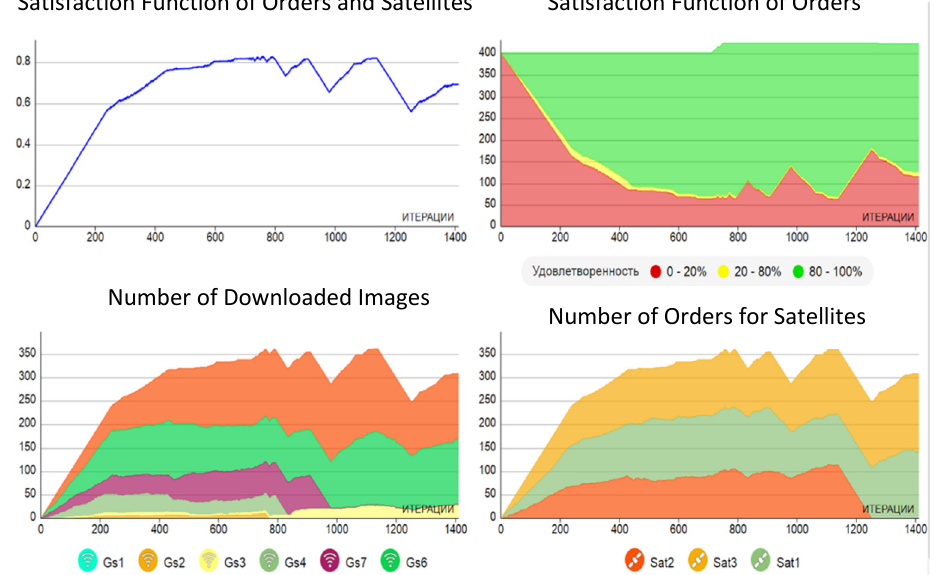
Figure 11. The example of resulting schedule of group of satellites.